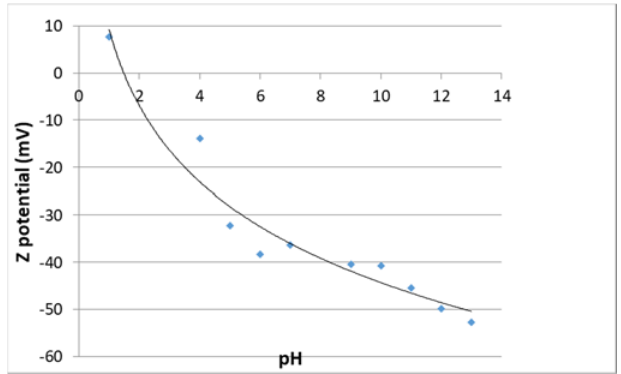
Figure 1. Z potential of activated carbon.